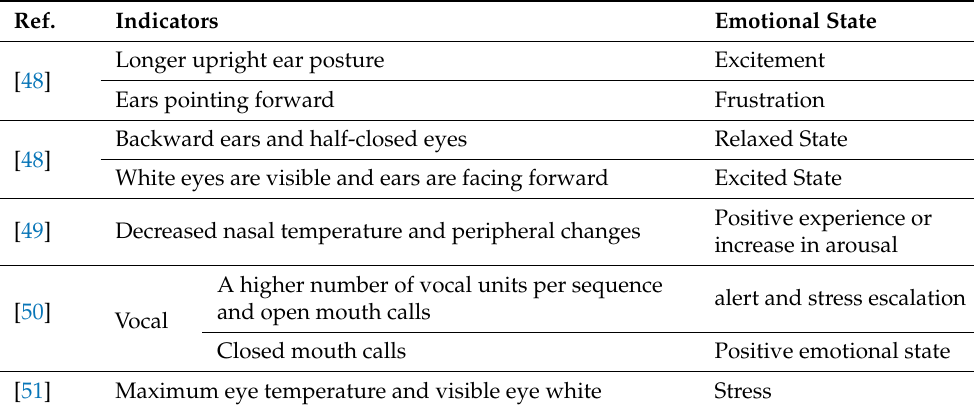
Table 1. The emotional state of dairy cattle animal (Cow).